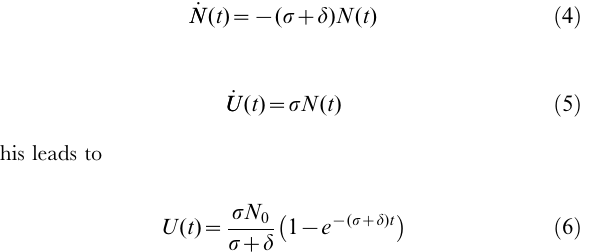
Figure S1 Distribution for the turning angle h . The distribution is shown in the absence of killing for the CTL velocities v h = 3.65 m m/min (A) and v h = 10.8 m m/min (B) and in the presence of killing for v h = 10.8 m m/min and t D = 15 min (C). Reduced velocity as well as killing activity slightly increases the mean turning angle. Figure S2 Investigating the influence of multiple killing on the simulations. (A) Histogram for the number of target cells killed per CTL for different CTL velocities. Killing duration of t D =15 min is fixed and a CTL frequency of C , 0.02 (= 450 cells) is used. Each simulation comprises 300 min ( v h = 3.73 m m/min (red), v h =6.91 m m/min (blue), v h =10.54 m m/min (black), v h =13.45 m m/ min (green), v h =19.45 m m/min (orange)). The average number of target cells killed per CTL increases with velocity. (B) The same data as in (A) analyzed for the time a CTL spents to perform multiple killing relative to the time it is bound in a conjugate. Figure S3 Plots of v h , v c and t D against the estimates of k . The estimation was based on either counting free and bound target cells (shown in A–C) or only free target cells (shown in D–F). The killing rate constant was estimated using the revised estimation method based on the proportion of target cells killed. The mean, the minimum and the maximum over 1000 bootstrap estimates are shown (neglecting outliers), as the 95% confidence intervals are, in most cases, too small to be plotted. Spearman’s rank correlation coefficient, r , is given. The color coding corresponds to the different levels of t D (5 min (orange), 10 min (green), 15 min (black), 30 min (blue), 60 min (red)). In each group of t D in C and F, the level of velocity is increasing from left to right. Found at: doi:10.1371/journal.pcbi.1000466.s003 (0.16 MB